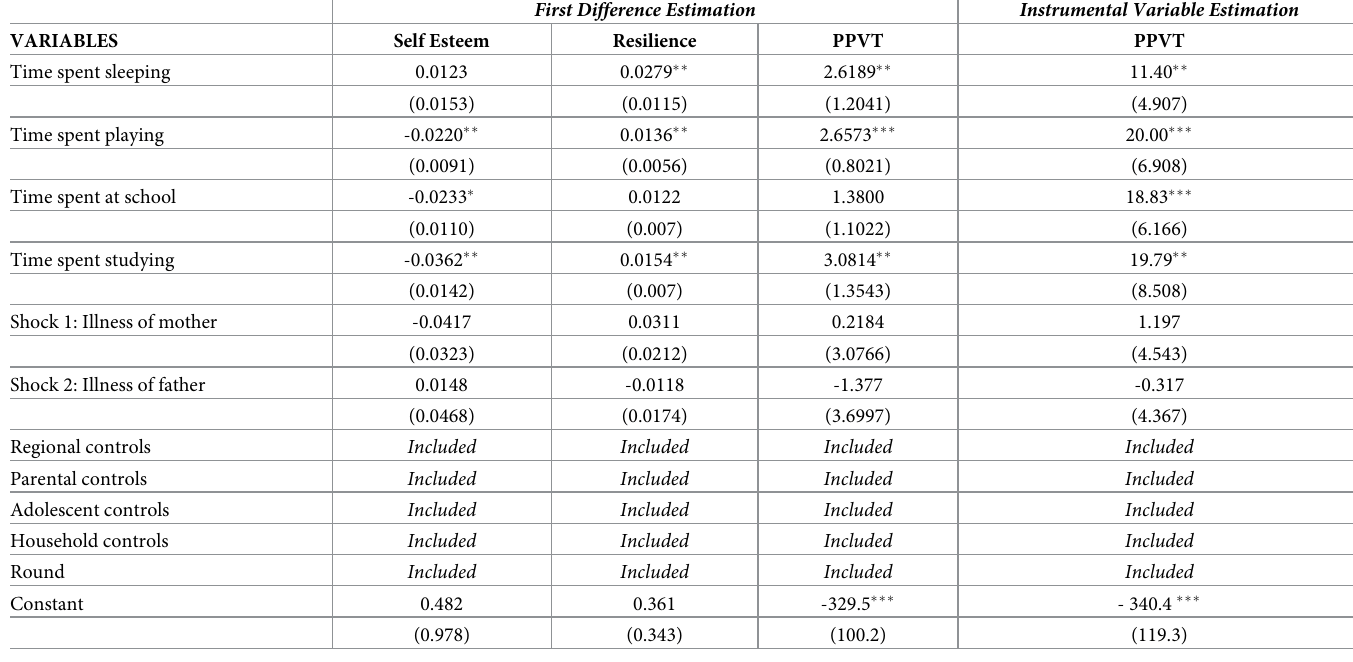
Table 5. First difference and instrumental variable estimations with shock